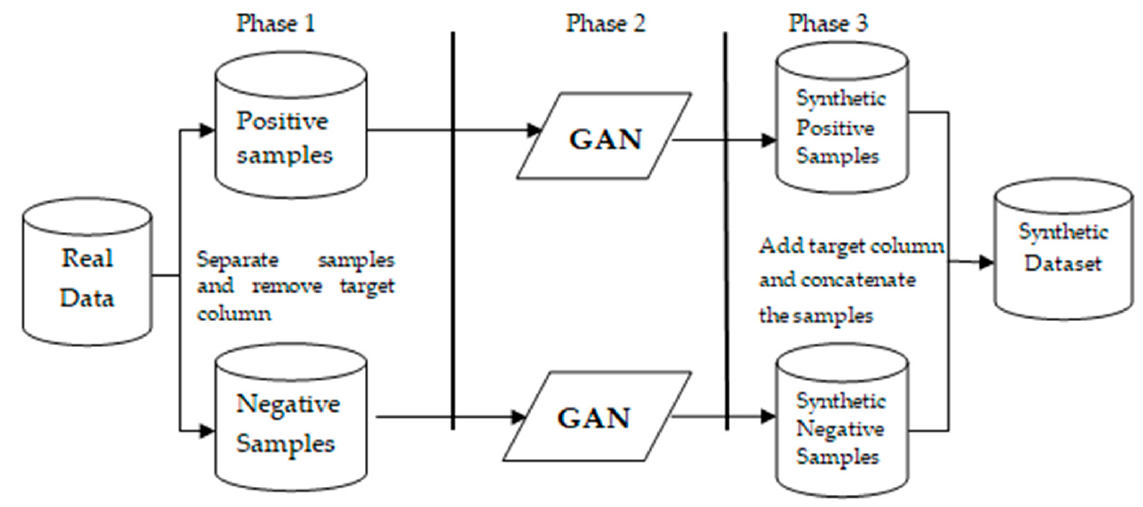
Figure 2. The architecture of the Duo-GAN. Duo-GAN employs two GANs: one to generate fraudulent synthetic transactions and the second to generate synthetic legal samples.